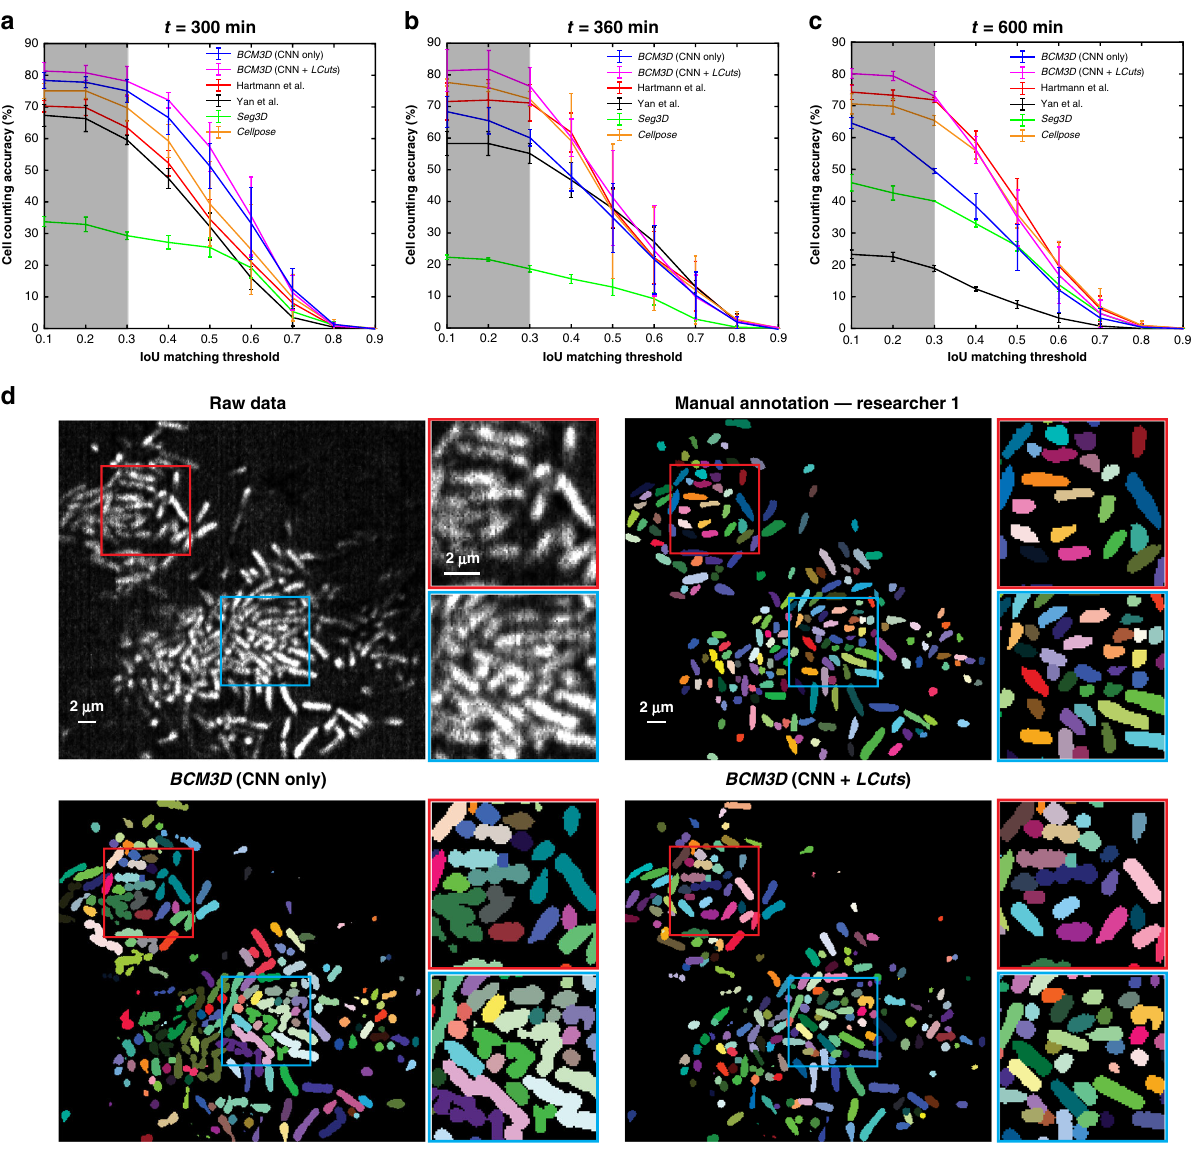
Fig. 4 Comparison of segmentation accuracies achieved by conventional segmentation approaches (Hartmann et al., Seg3D, Yan et al.), Cellpose, and BCM3D . The estimated SBRs are 2.2, 1.8, and 1.3, respectively. The estimated cell densities are 54.8%, 59.0%, and 64.6%, respectively. a – c Three experimental E. coli datasets (cytosolic expression of GFP) acquired at different time points after inoculation of cells. Segmentation accuracy is parameterized in terms of cell counting accuracy ( y -axis) and IoU matching threshold ( x -axis). Each data point is the average of the cell counting accuracies calculated using annotation maps traced by N = 3 different researchers. Data are presented as mean values ± one standard deviation indicated by error bars. Curves approaching the upper right-hand corner indicate higher overall segmentation accuracy. d Comparison of segmentation results achieved at the t = 600 min time point by manual annotation (shown is one of N = 3 researchers ’ annotation result, the other two annotation results are shown in Supplementary Fig. S4), and by BCM3D using in silico-trained CNNs only and after further re fi nement of CNN outputs using LCuts. Similar results were also obtained at the t = 300 and t = 360 min time points. Segmentation results of the other methods are shown in Supplementary Fig. S4. Source data are provided as a Source data fi le for Fig. 4a –